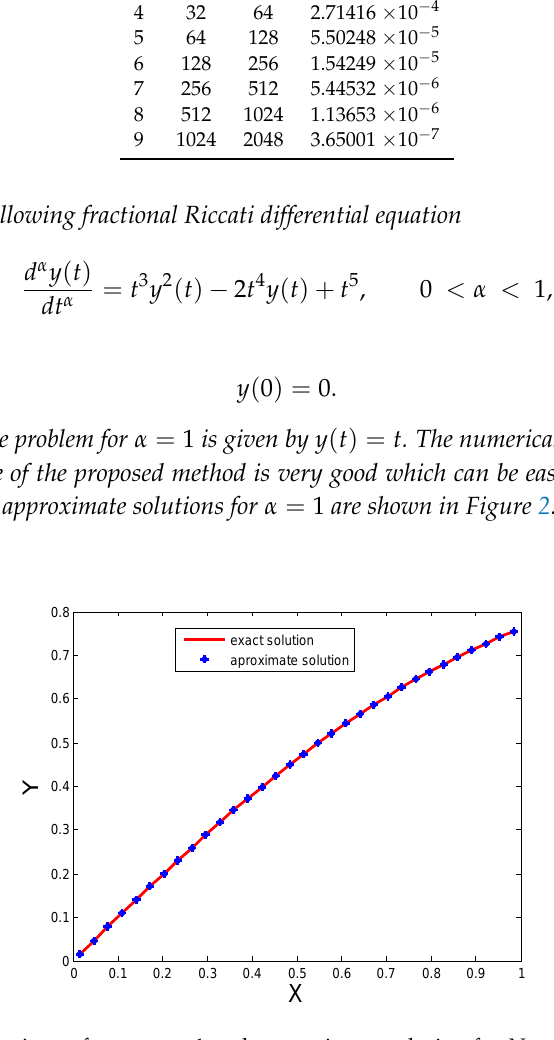
Figure 1. Comparison of exact α = 1 and approximate solution for N = 32 for Example 1. Table 4. Maximum estimated absolute errors for α = 1